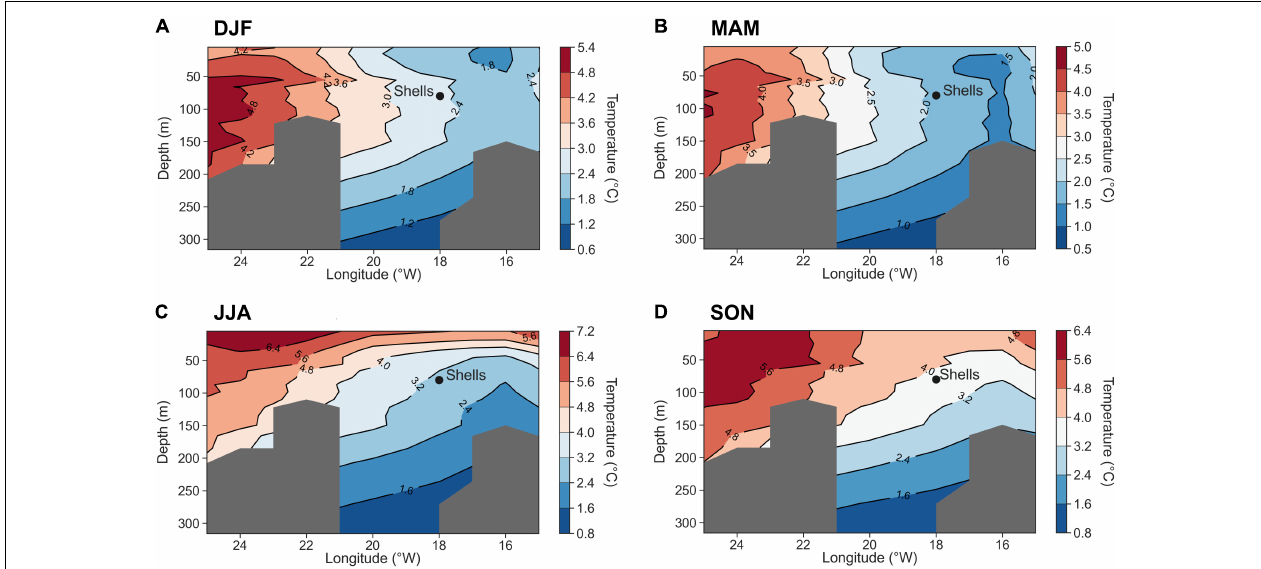
FIGURE 5 | Seasonal temperature-depth profiles along a longitudinal transect (25 ◦ W–15 ◦ W; 66 ◦ N). The EN4.2.1 temperature fields were averaged for (A) winter, (B) spring, (C) summer and (D) autumn for the period 1900–2005. The gray-shaded areas represent no available